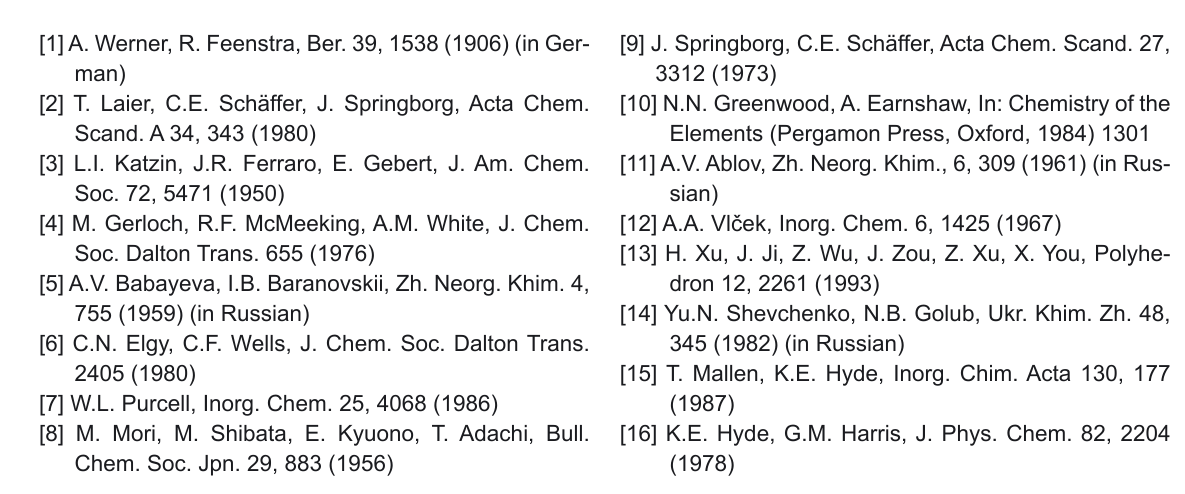
Cl ] + py reac- 3 3 3